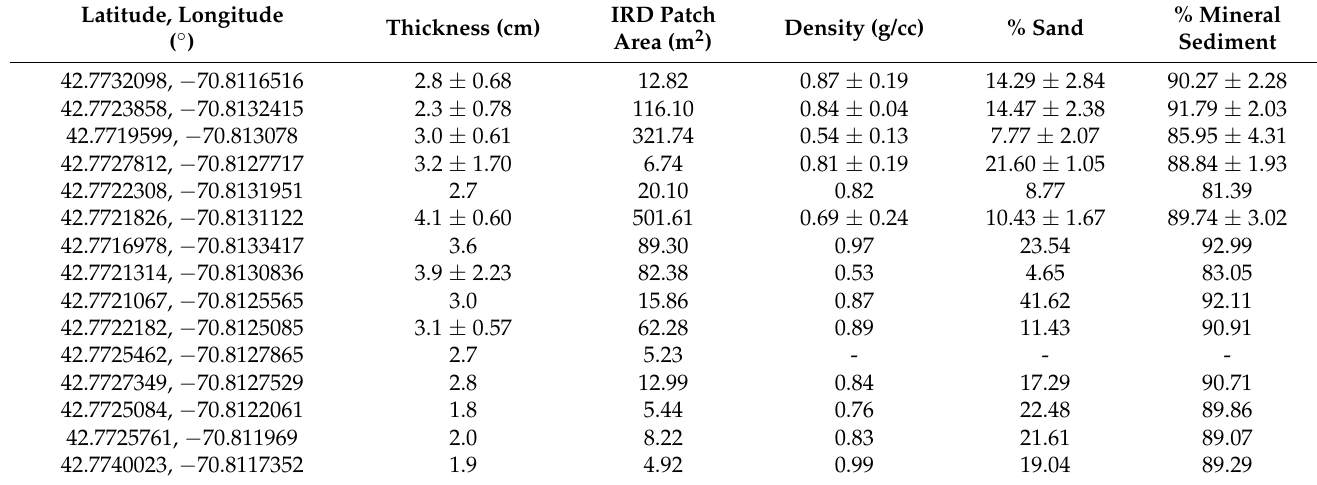
Table 1. Field measurements of 15 patches of deposited IRD within the study site. Thickness measurements were taken at multiple points within some large patches. Standard deviation is included for those averaged thickness values. Mean values of density, percentages of sand and organic matter for each patch are reported with their standard